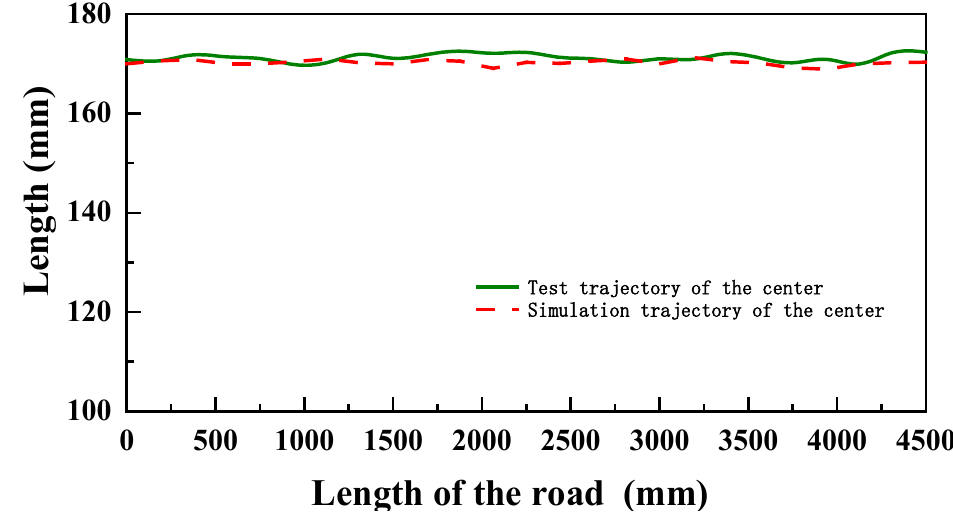
Figure 25. The trajectory of the center of the mobile chassis on the pothole road.